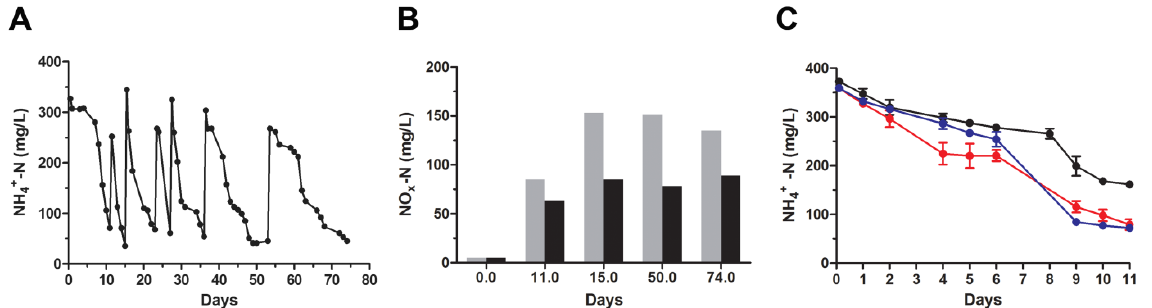
Figure 4. Repetitive re-inoculum assay. ( A ) The activated sludge (10 mL), corresponding to 150 mg dry weight, was mixed with 30 mL of LMM essentially as described in the legend of Figure 2. The culture was placed in a water bath shaker at 28 °C and ammonia concentrations were estimated using Nessler’s test, at the starting point (indicated with day 0) and at regular intervals for the next 75 days. At each NH 4+ fall, 10 mL of the culture was re-inoculated in fresh LMM (30 mL) and ammonia concentration was adjusted over again to ~350 mg/L (peaks). ( B ) Samples from RRIA were withdrawn at NH 4+ falls to determine nitrite and nitrate and their values, expressed as NO 2 − -N (grey bars) and NO 3 − -N (black bars), respectively, have been plotted. Data represent the average of three independent experiments and the standard deviation is ~10%. ( C ) The curves of the NH 4+ removal rate in LMM for sludge ( ● ) and G5-2 (27 days, ● ) and G5-4 (53 days, ● ) communities are shown. The initial cell number of the cultures was ~5 × 10 6 cells/mL as determined by plating bacteria on Luria–Bertani solid medium after serial dilutions.